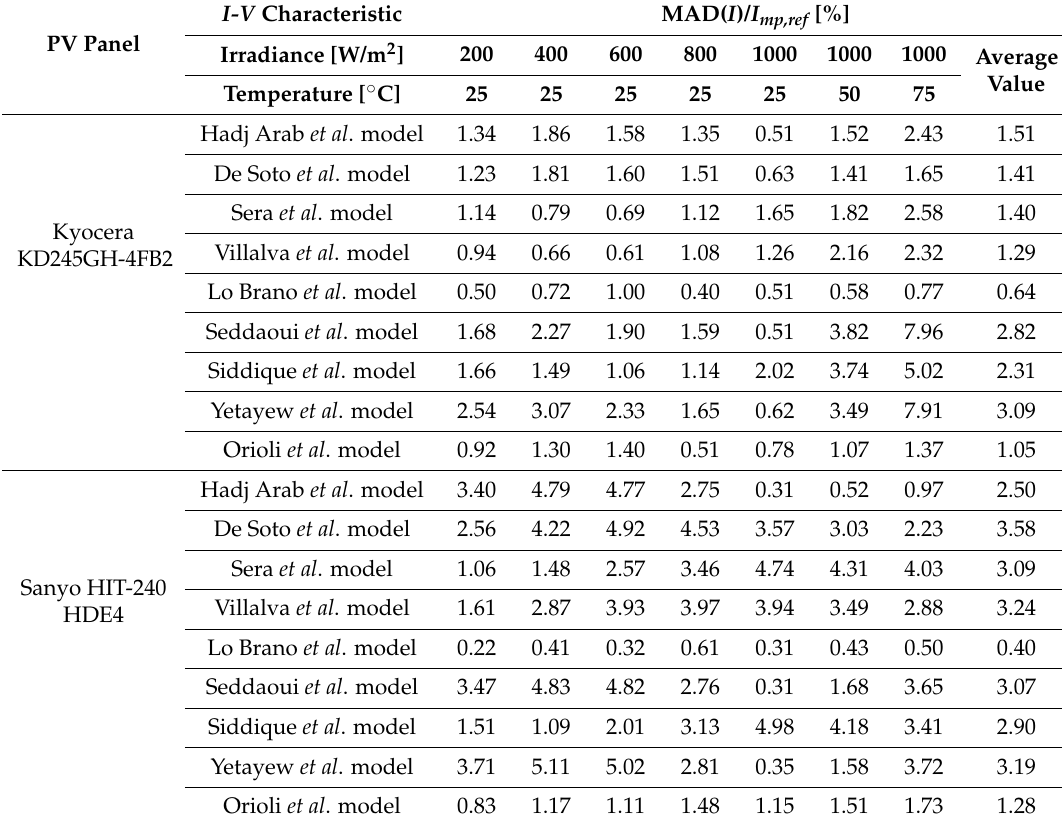
Table 15. Percentage ratio of the mean absolute difference, MAD( I ) to the rated current at the maximum power